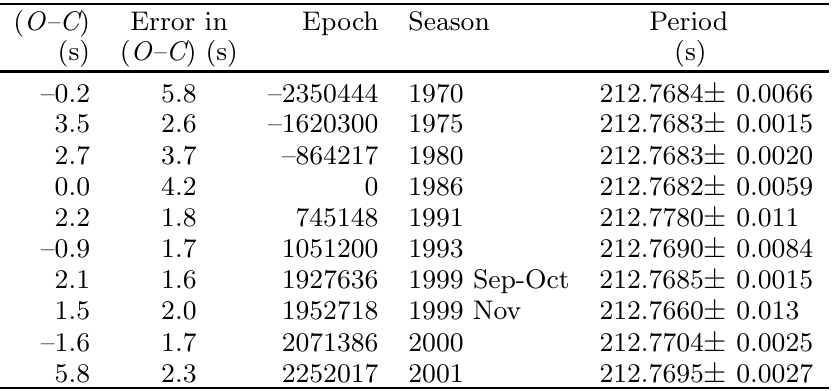
Table 3. ( O-C ) Table for period P = (212.76842927